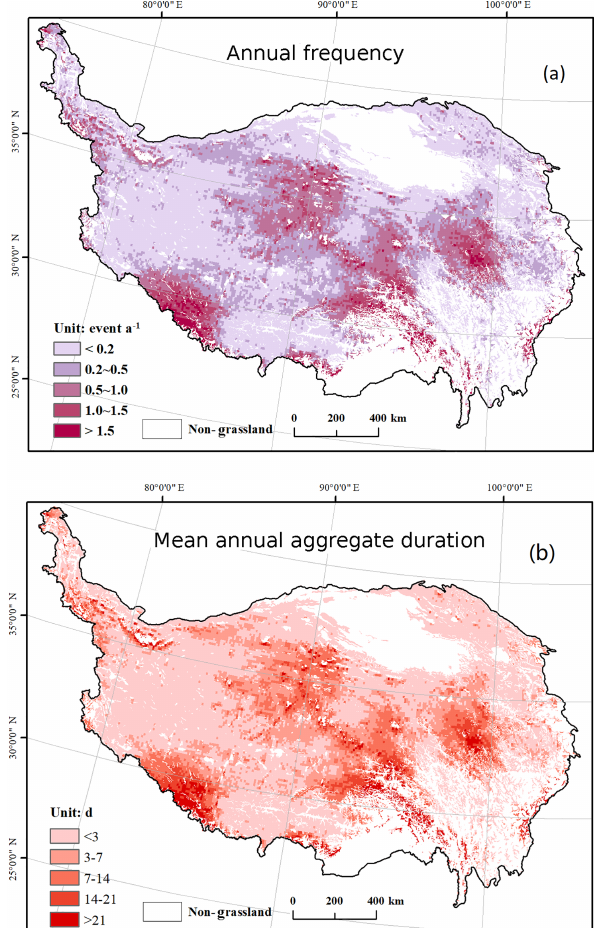
Figure 5. Gridded annual frequency and annual-average occur- rence (a) and mean annual aggregate duration (b) of snow disasters from model